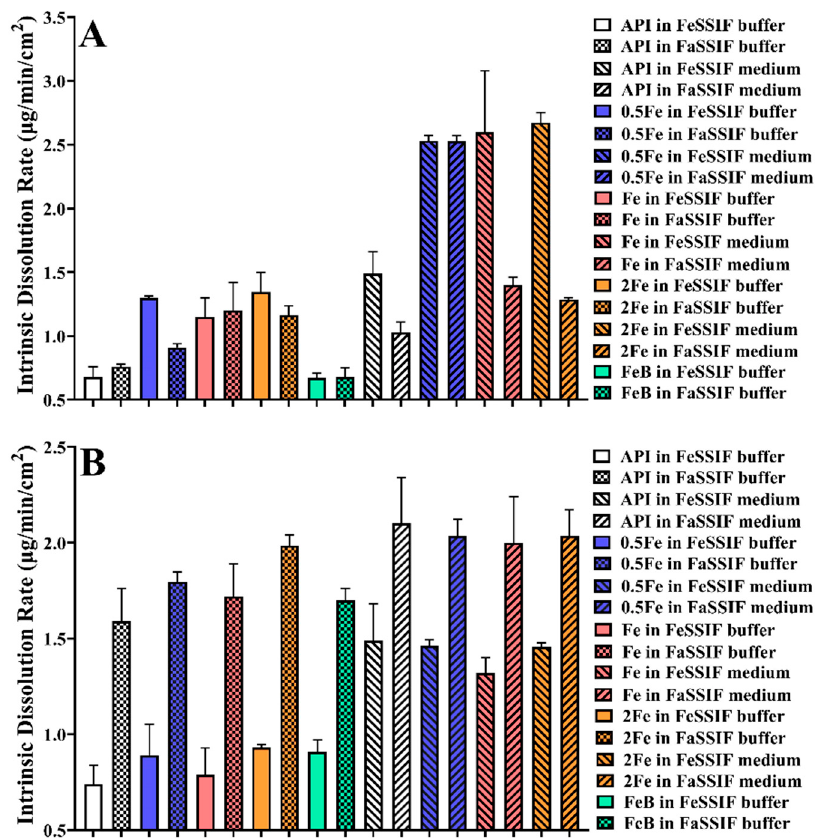
Figure 7. The intrinsic dissolution rate of different samples in various media. ( A ): Rivaroxaban; ( B ): Drug-A. (FeB, 0.5 Fe, Fe, and 2 Fe indicate that precipitate comes from the medium of FeSSIF buffer, 0.5 × FeSSIF, FeSSIF, and 2 × FeSSIF, respectively).